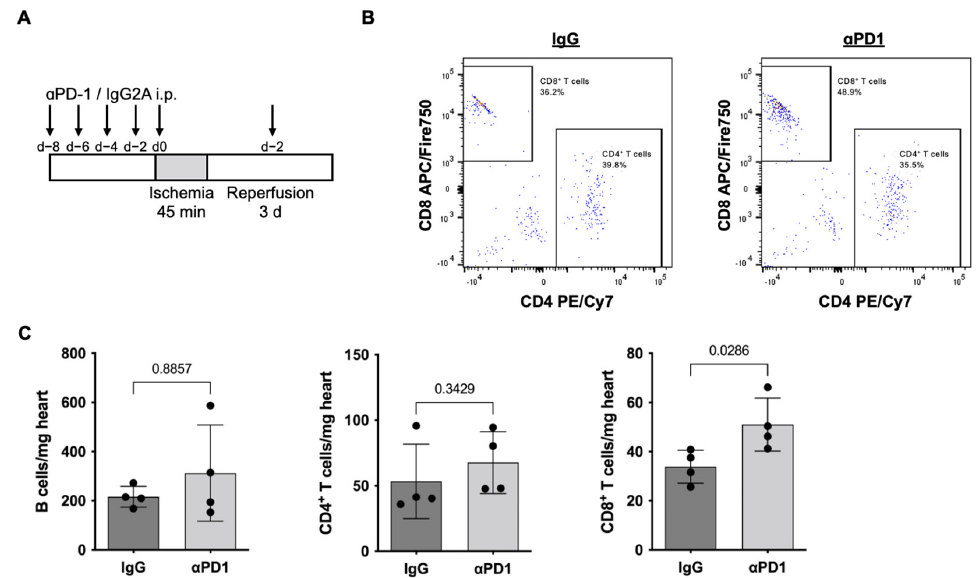
Figure 5. Increasing CD8 + T cells following repAMI in anti-PD1-treated mice. ( A ) Treatment scheme of mice receiving anti-PD1 therapy or IgG2A control followed by induction of repAMI with subsequent treatment and 72 h reperfusion. ( B ) Exemplary flow cytometry data showing CD3 + T cells stratified for CD4 + and CD8 + . ( C ) Quantification of B cells, CD4 + T cells, and CD8 + T cells per mg heart tissue ( n = 4 per group). Black dots indicate individual samples.